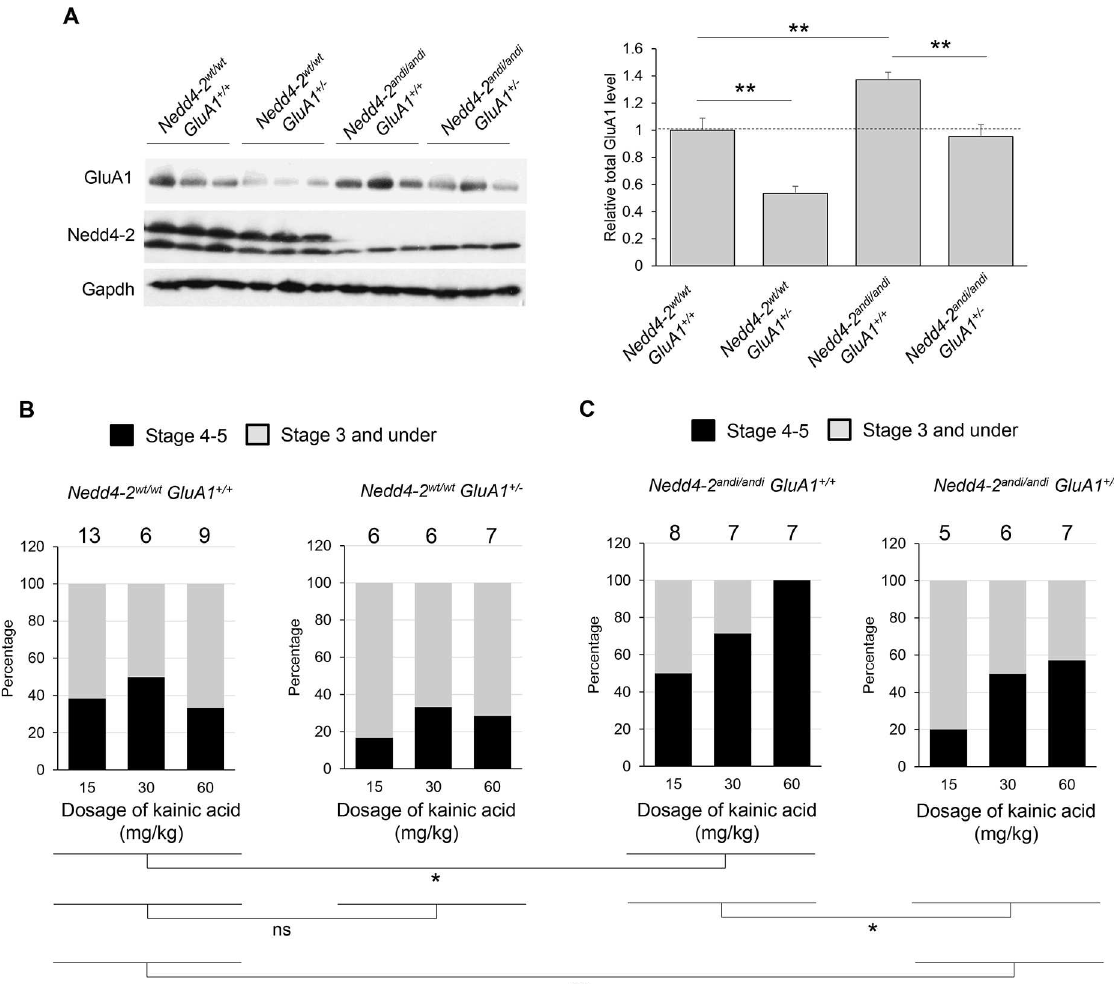
Fig 4. Genetically reducing GluA1 normalizes elevated seizure susceptibility in Nedd4-2 andi mice. ( A ) Western blots of GluA1, Nedd4-2, and Gapdh from 3 representative mice of each of the 4 genotypes: Nedd4-2 wt/wt GluA1 +/+ , Nedd4-2 wt/wt GluA1 +/- , Nedd4-2 andi/andi GluA1 +/+ , and Nedd4-2 andi/andi GluA1 +/- . Quantification of GluA1 is shown on the right (Six mice of each genotype were obtained for quantification.ANOVA with post-hoc Tukey test, ** p < 0.01). ( B ) Four-weekold mice with each of the 4 genotypes mentioned in ( A ) were intraperitoneally injected with kainic acid (15, 30, or 60 mg/kg). The numberof mice used in each conditionis shown on the top of each bar. Mice showingstage 4 and/or 5 seizureactivity are countedas 1 whilemice showing stage 3 seizureor under are counted as 0. The statistical results after a 2-way ANOVA with post-hoc Tukey test are as below: Nedd4-2 wt/wt GluA1 +/+ vs Nedd4-2 andi/andi GluA1 +/+ , * p < 0.05; Nedd4-2 andi/andi GluA1 +/+ vs Nedd4-2 andi/andi GluA1 +/- , * p < 0.05; Nedd4-2 wt/wt GluA1 +/+ vs Nedd4-2 wt/wt GluA1 +/- , p > 0.05; Nedd4-2 wt/wt GluA1 +/+ vs Nedd4-2 andi/andi GluA1 +/- , * p >